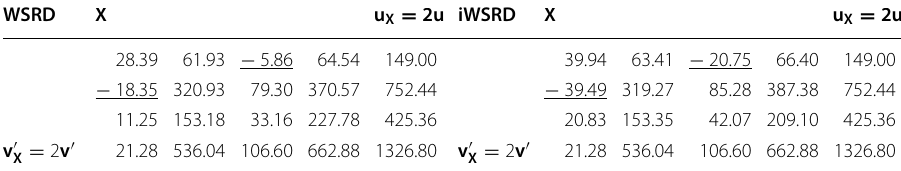
With the same location of underlined matrix elements as in Table 10